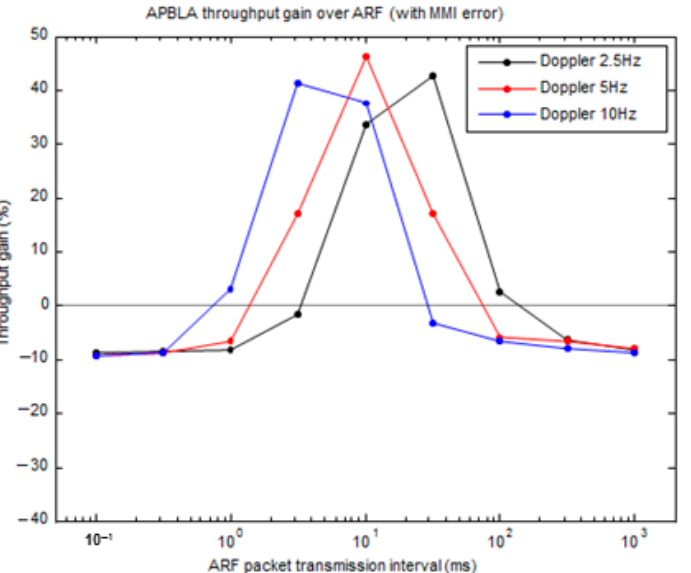
Figure 19. Throughput gain of APBLA relative to ARF as a function of the packet transmission interval over some Doppler frequencies (1-tap channel).